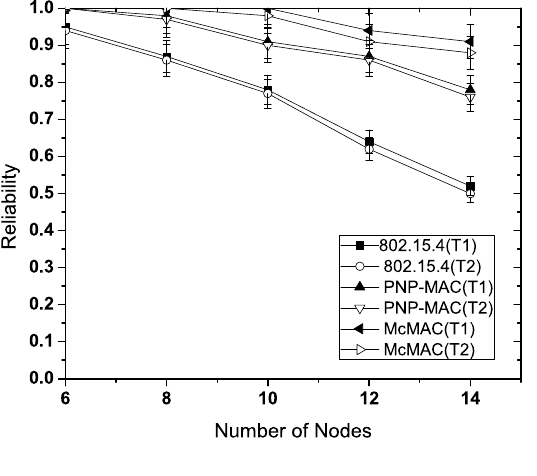
Figure 10. Reliability at varying number of nodes with emergency